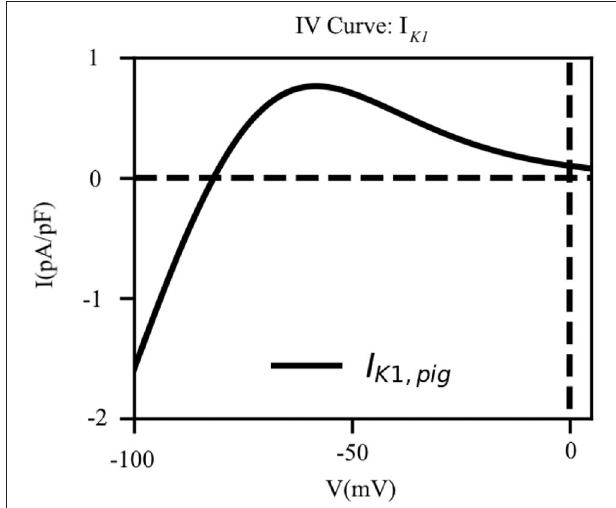
FIGURE 4 | The current-voltage characteristic of the inward rectifier K + current ( I K 1 ). The direction of flow of the current across the cell membrane reverses at E K = − 81.76 mV which is close to our experimentally measured resting membrane